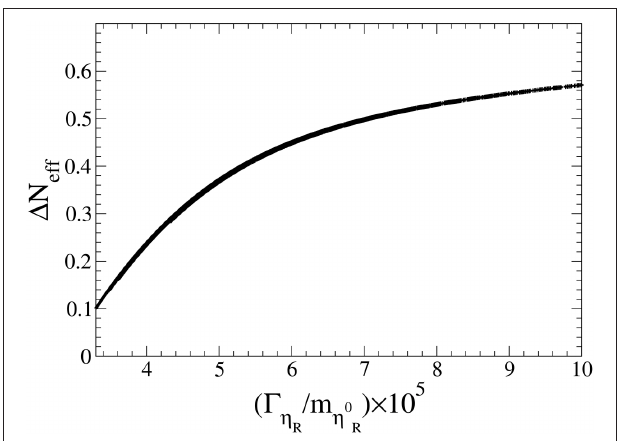
FIGURE 12 | 1 N eff against Ŵ η R / m η 0 parameters as for Figure 11 .